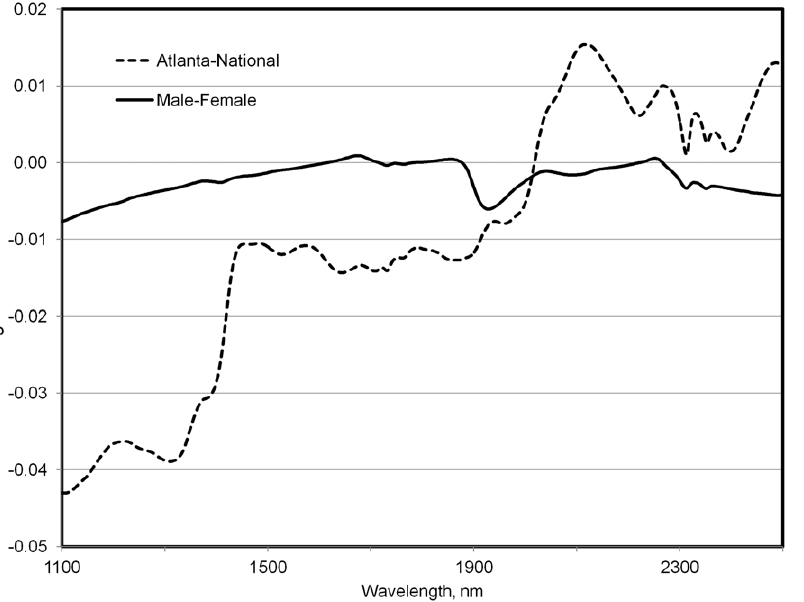
Figure 2. Fecal near infrared difference spectra (log 1/reflectance, derivative=0, gap=0) from adult M-F pandas versus all pandas from two zoos.